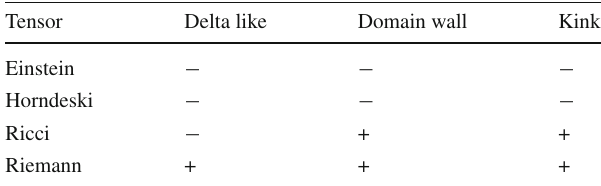
Table2 Theplussignalmeansappearanceofresonantpeaks,theminus absence for p